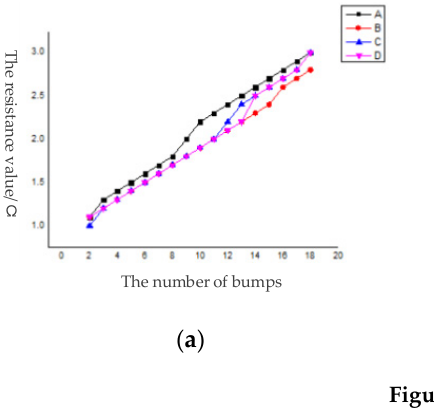
Figure 13. Result of the binding test after optimization of parameters.